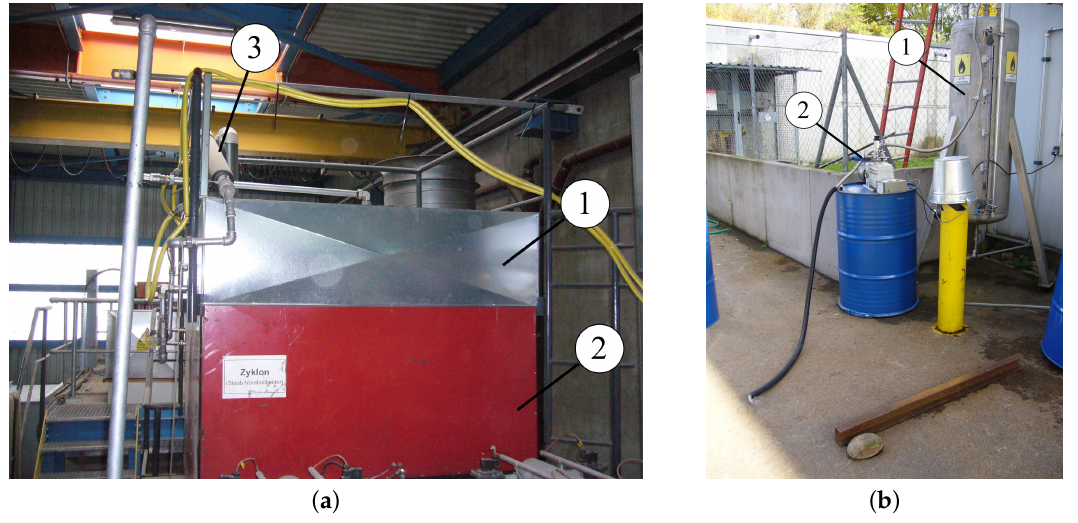
Figure 8. ( a ) Distilling apparatus on top of multi-cyclone/exhaust gas duct; ( b ) new fluid reservoir for low boiler extraction and membrane